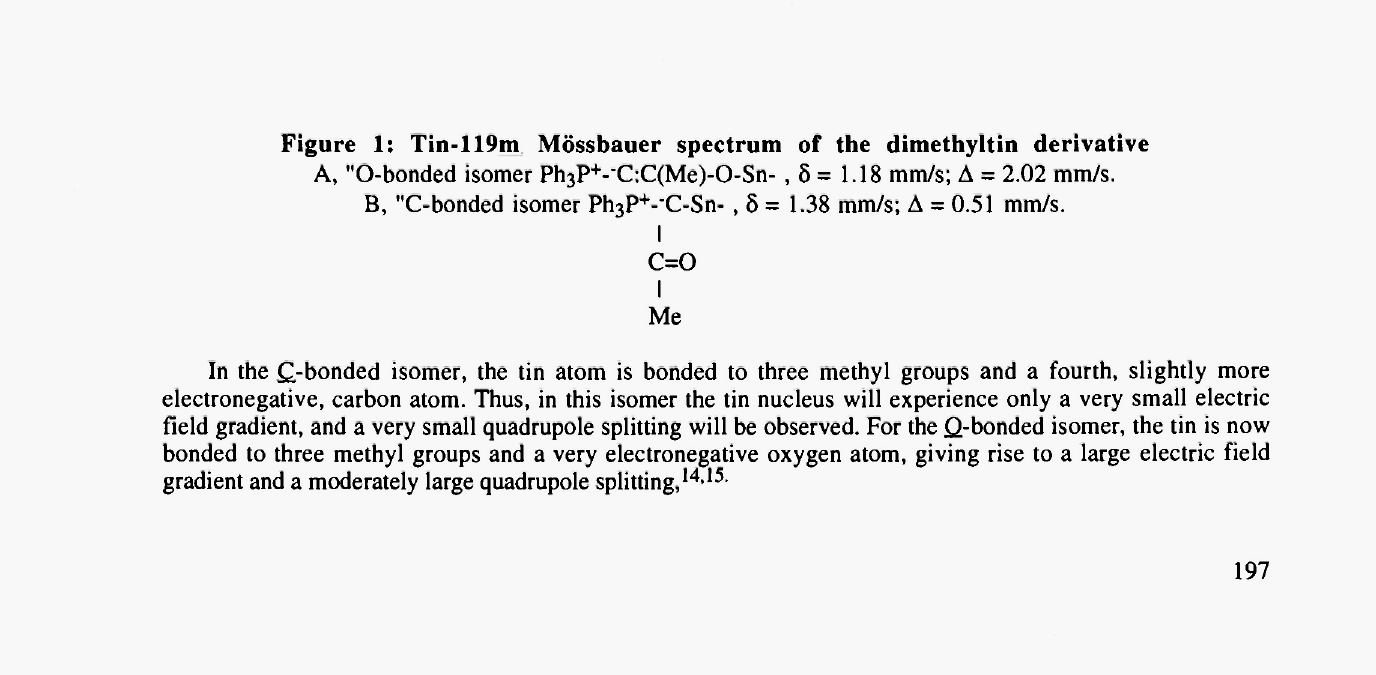
Figure 1: Tin-119m Mössbauer spectrum of the dimethyltin